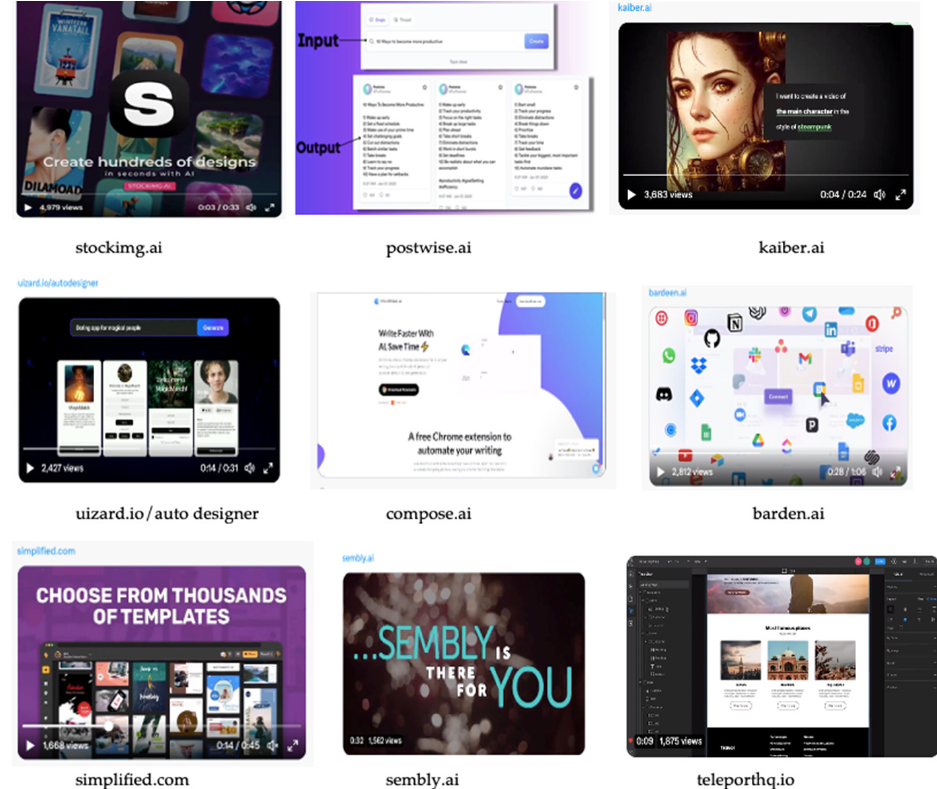
Figure 1. GAI applications for product design for every sector. Source: authors’ conception.